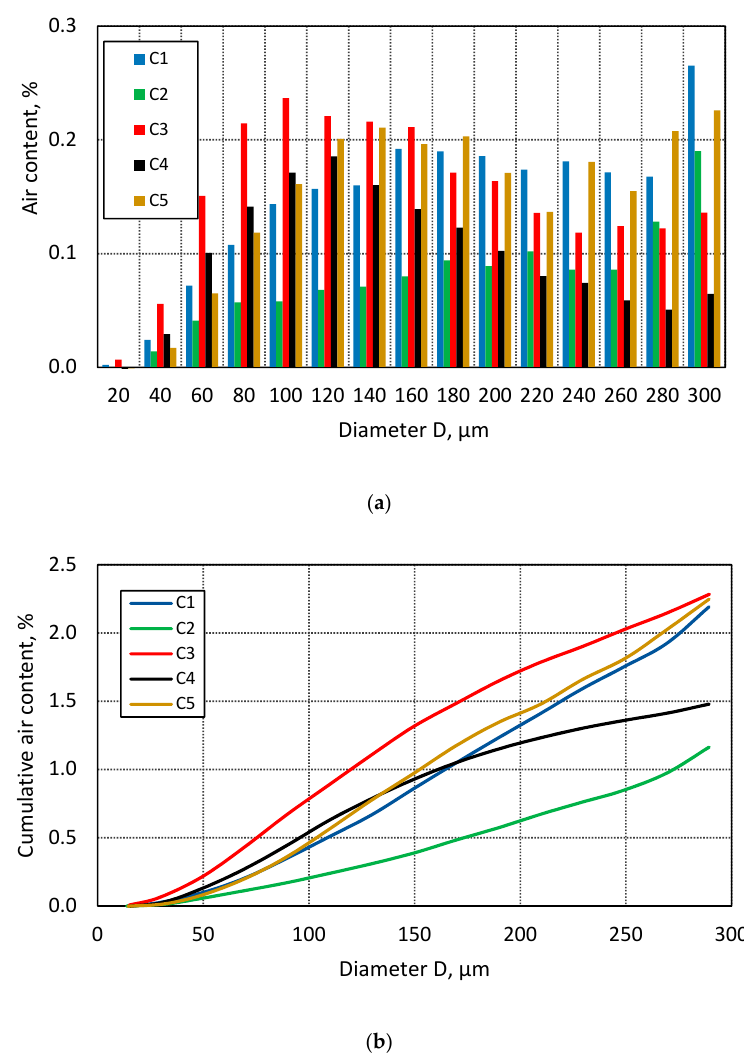
Figure 5. ( a ) Air content in a given class, ( b ) cumulative air void volume for concretes C1–C5 (2D m). Materials 2020 , 13 , x FOR PEER REVIEW Table 6. Consistency of the results obtained by the given method with the standard-based results— root mean square relative deviation of all the results.